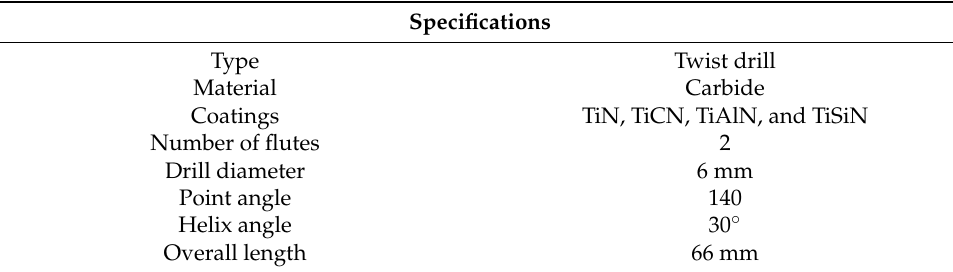
Table 2. Description of the drill